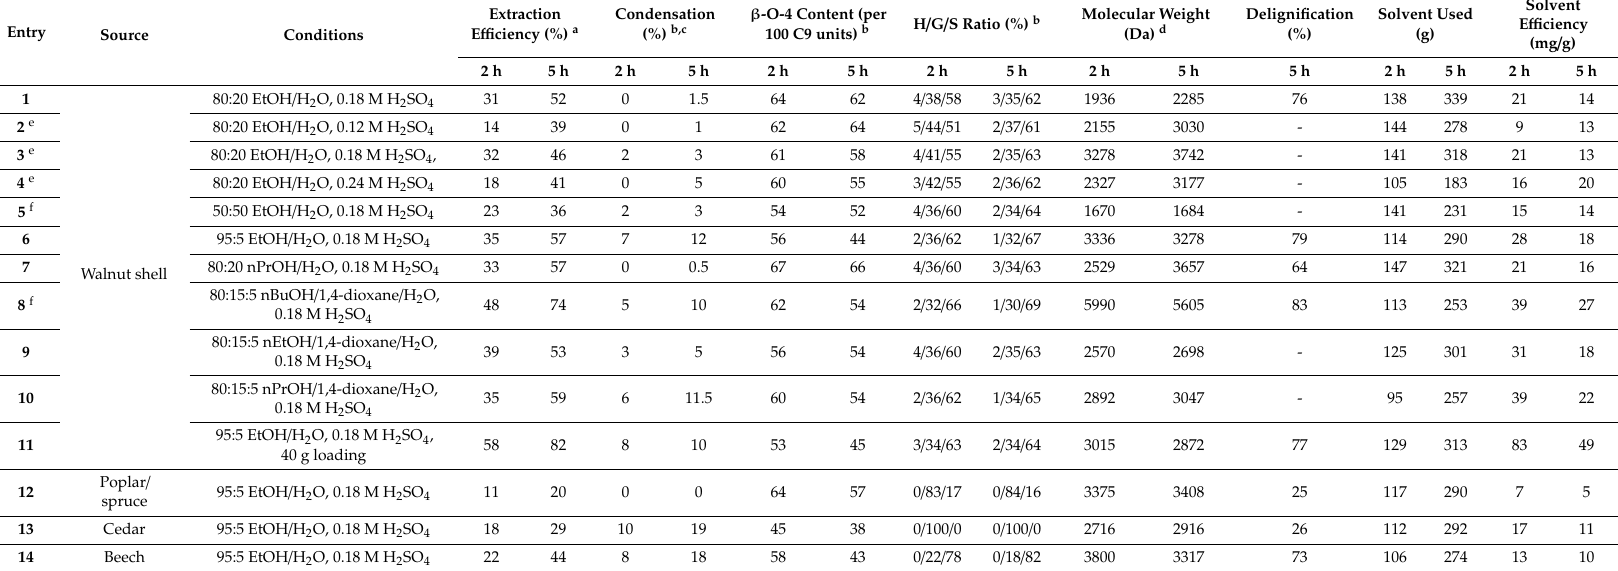
Table A1. Overview of extraction e ffi ciencies and lignin properties of all extractions performed in the flow setup. All results of 2 and 5 h extractions are weight average properties. a Corrected for alcohol incorporation determined by HSQC, b determined by HSQC, c based on the amount of condensed S units (S condensed ), d determined by GPC (THF), e manually ground walnut shell, f 4 h extraction due to the reactor clogging. Data per 1 hr interval are reported in Tables S1–S14 and the formula for the calculations of the average values is given in SI